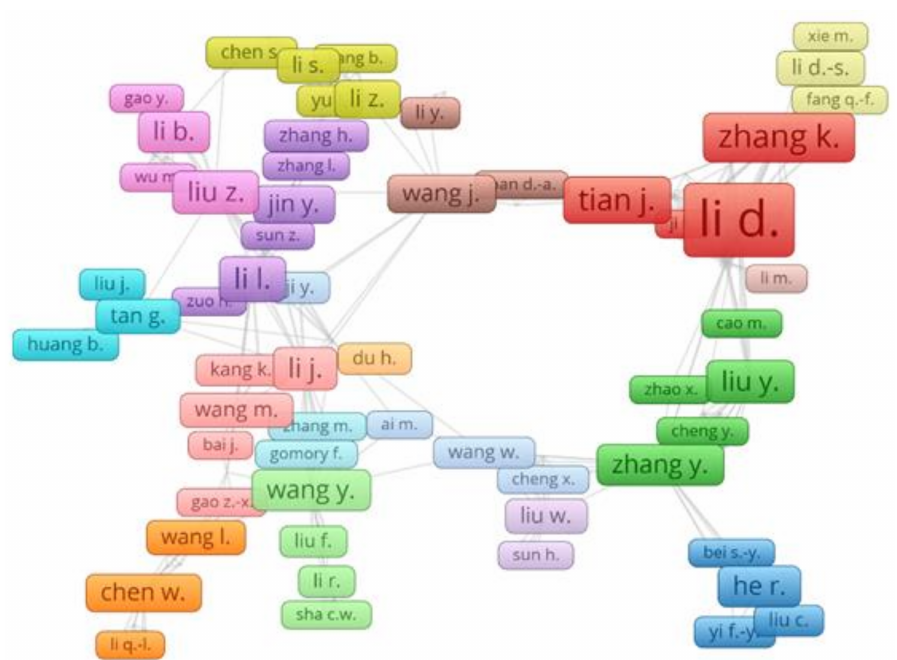
Figure 4. Co-authorship analysis using